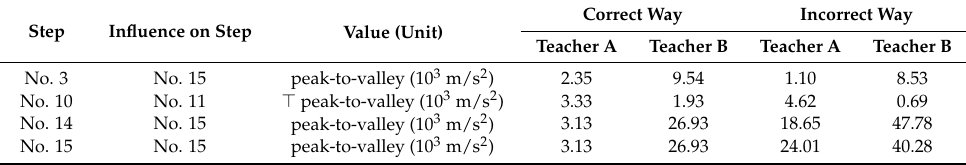
Table 2. Translational acceleration in translational acceleration of